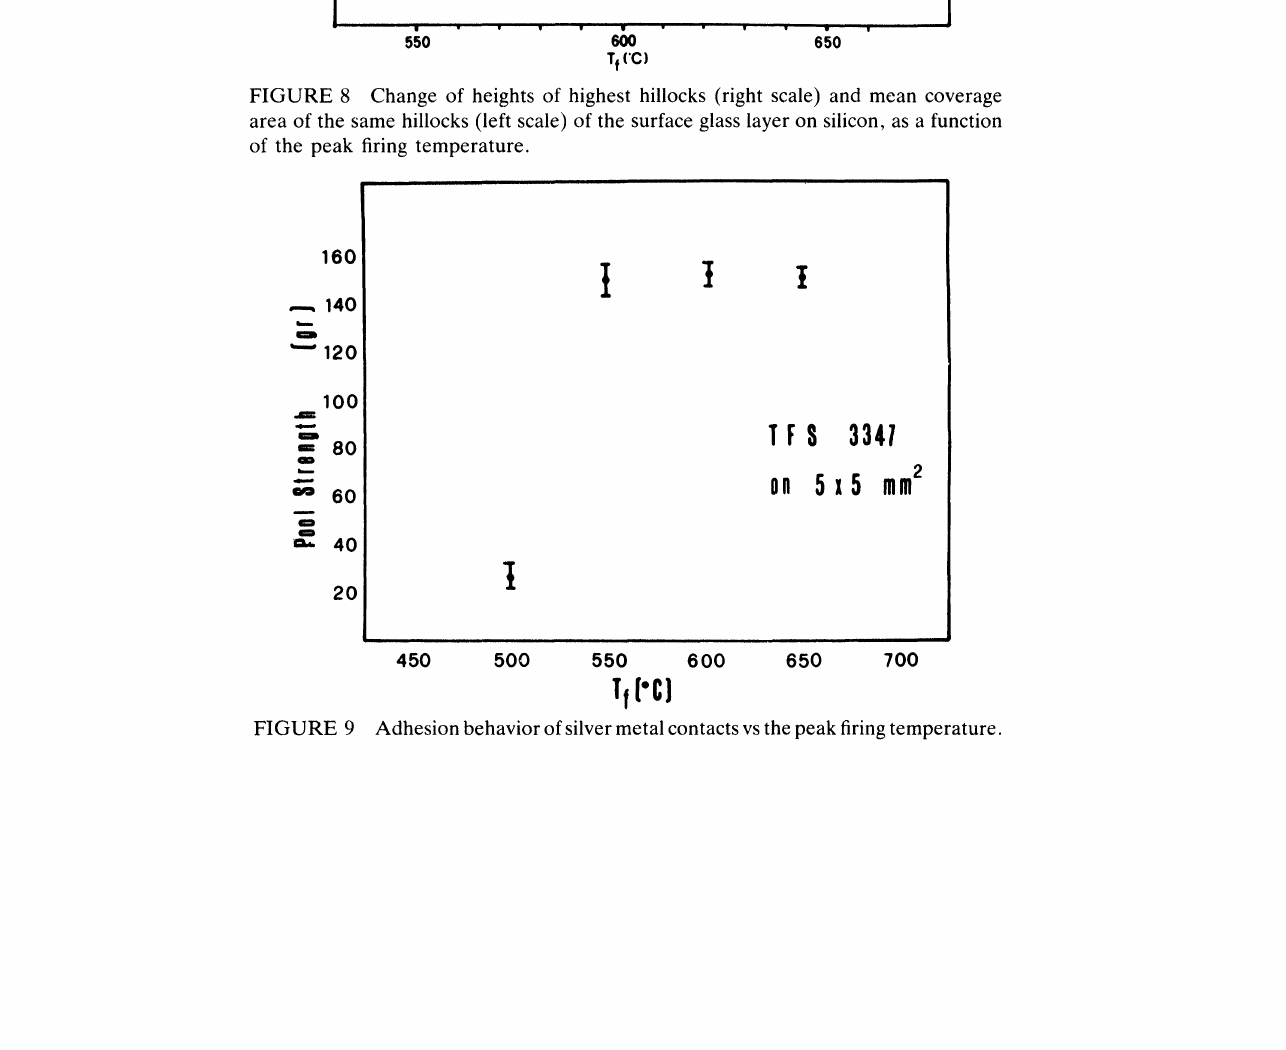
FIGURE 9 Adhesion behavior of silver metal contacts vs the peak firing